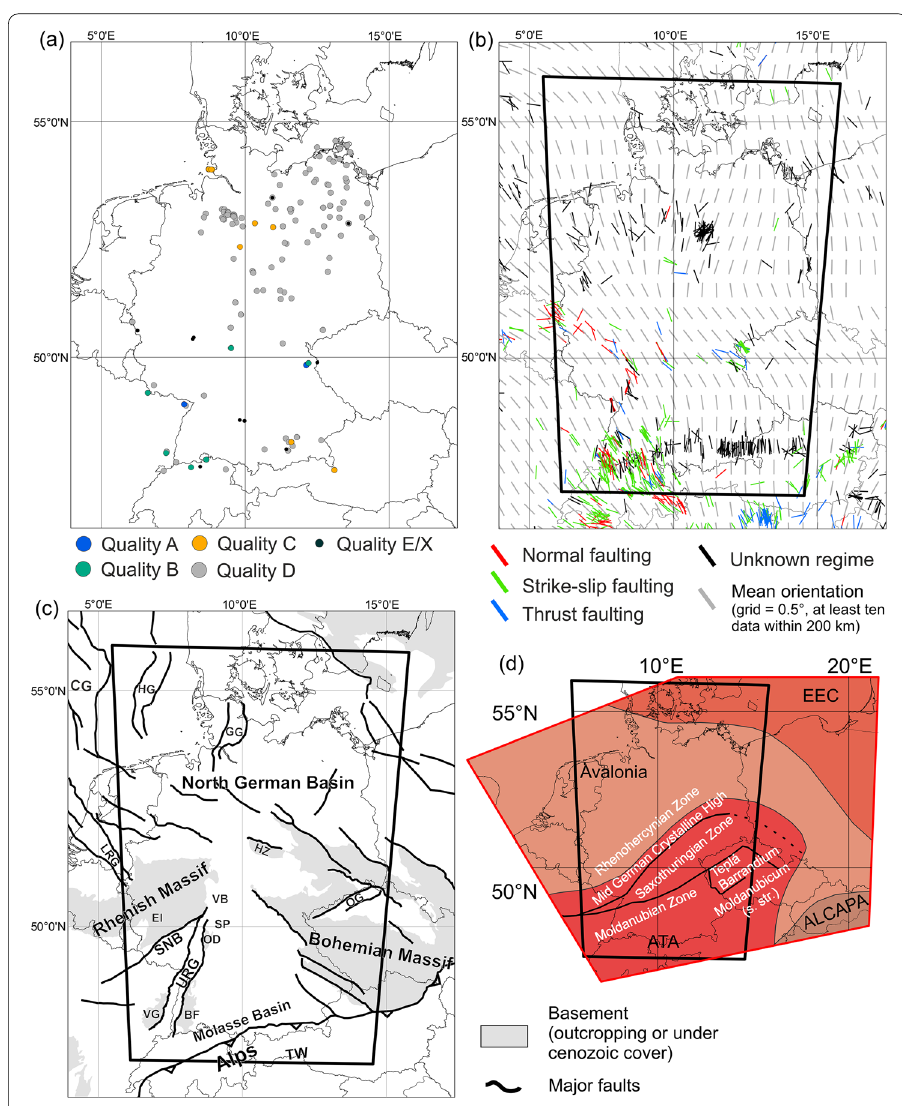
Fig. 1 Overview of the geology of the model region and stress data used for comparison and calibration. The black frame shows the key area of the model with increased stratigraphic resolution based on Anikiev et al. (2019). a Distribution of the stress magnitude data of Morawietz and Reiter (2020). The color‑coded dots indicate the quality assigned by Morawietz et al. (2020). Displayed are all data from a true vertical depth (TVD) > 200 m. b Data of the World Stress Map (WSM) of Heidbach et al. (2016) and Levi et al. (2019). Color‑coded lines indicate the stress regime and the orientation of S Hmax. Grey lines show the mean orientation of S Hmax on a regular grid (Details see chapter 3.1). c Geological framework of the model area based on Asch (2005) and Kley and Voigt (2008). BF—Black Forest, CG—Central Graben, EI—Eifel,